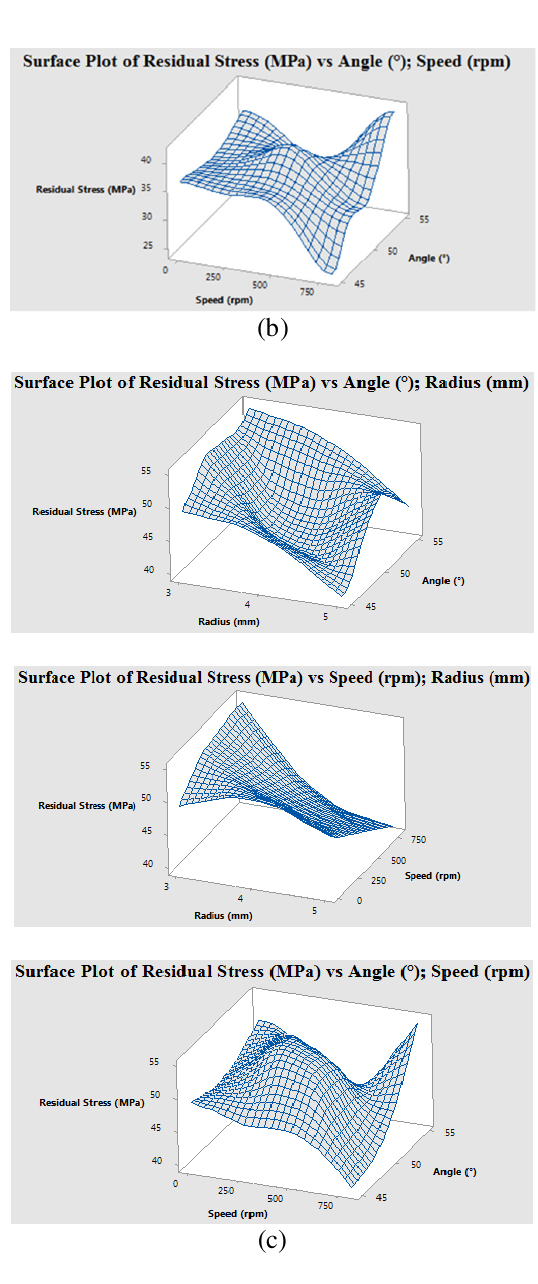
Fig. 10. The results using: (a) Ball end tool. (b) Hemispherical tool. (c) Flat with round corner